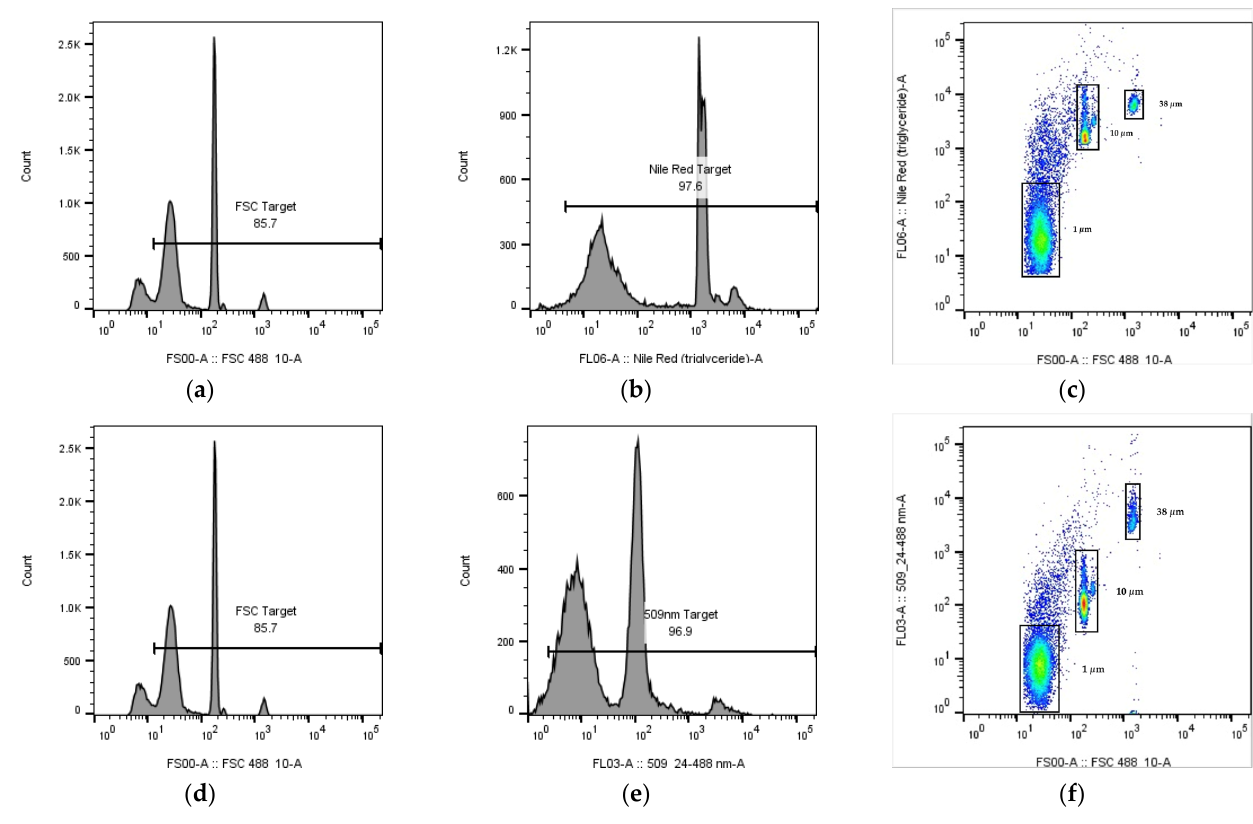
Figure 2. Flow cytometric analysis of PS calibration beads (1, 10 and 38 µm) with ( a ) gating of signal count of FSC (for emission filter at 583 nm); ( b ) gating of signal count of NR fluorescence (emission filter at 583 nm); ( c ) NR fluorescence vs. FSC signal plots after gating (for emission filter at 583 nm); ( d ) gating of signal count of FSC (for emission filter at 509 nm); ( e ) gating of signal count of NR fluorescence (emission wavelength at 509 nm); ( f ) NR fluorescence vs. FSC signal plots after gating (for emission filter at 509 nm).